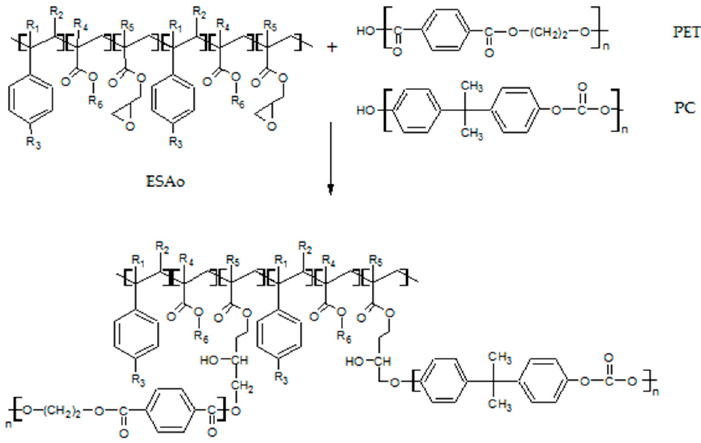
Figure 3. Possible reactions involved during the extrusion of the POST-I blend with ESAo.